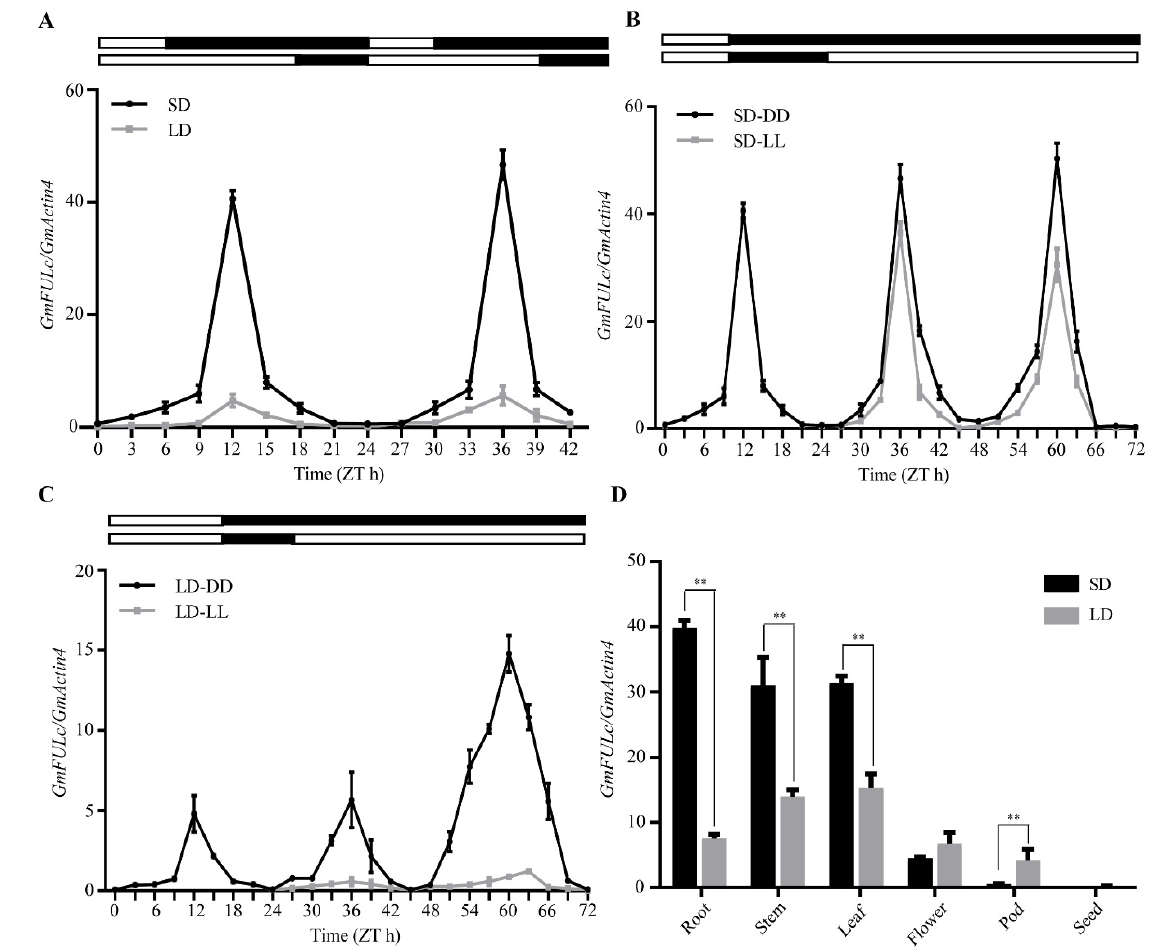
Figure 2. GmFULc expression patterns analysis. A photoperiod-sensitive soybean variety, “Dongnong 42”, was grown in LDs (16 h light/8 h dark) for 10 days and then transferred to SDs (8 h dark/16 h light) or LDs for sampling at 3-h interval. ( A ) The expression levels of GmFULc in SDs and LDs. ( B ) Expression patterns of GmFULc transcripts under LL and DD conditions from SDs. ( C ) Expression patterns of GmFULc in LL and DD conditions from LDs. White and black bars at the top represent the light and dark phases, respectively. ( D ) Tissue-specific expression of GmFULc at ZT 12 h in SDs and LDs. Data are means ± standard errors of the mean (SEM) of three independent experiments. Significant differences between the expression level of GmFULc under SDs and LDs are indicated by asterisks. Student’s t -test, ** p < 0.01.